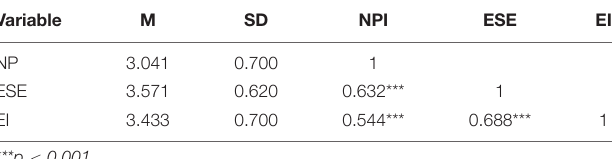
TABLE 1 | Descriptive analysis and correlation analysis of the variables.